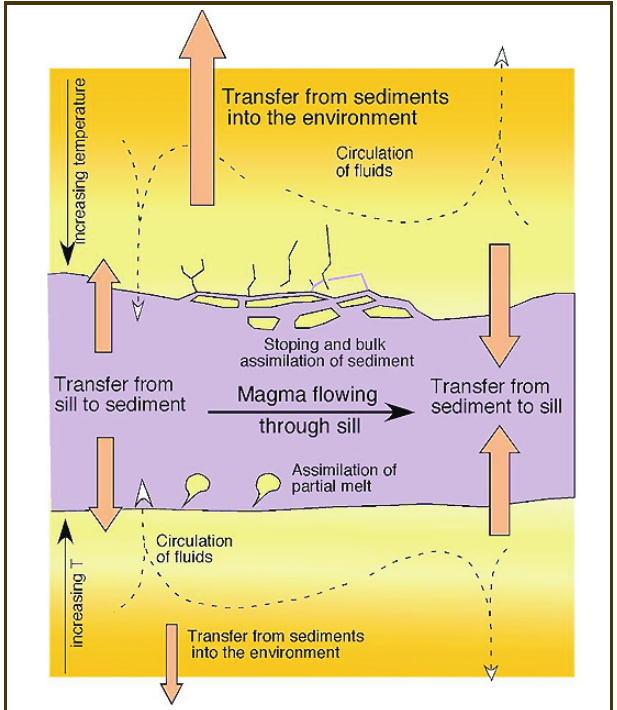
Figure 8. Hypothetical representation of sill-sediment interaction and the release of gases liberated from the sedimentary